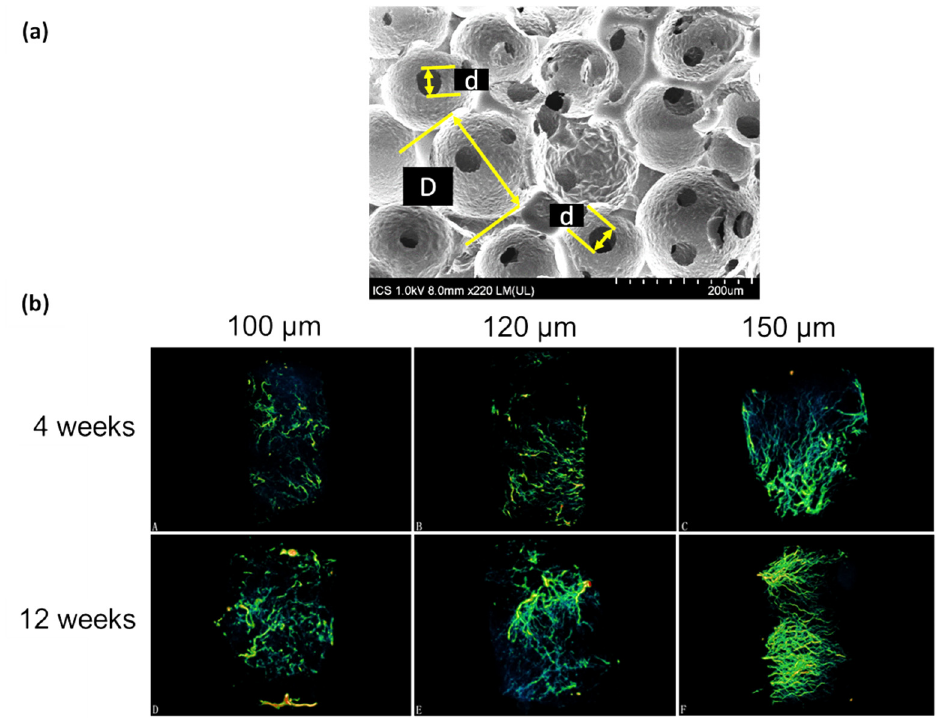
Figure 5. ( a ) SEM image of a porous scaffold produced by sphere templating where “D” indicates the pore diameter and “d” the interconnection diameter (Image taken by G. Lutzweiler). ( b ) Evolution of the blood vessels within a porous scaffold as a function of time with varying interconnection diameters (100, 120, and 150 µm). Adapted from Xiao et al . [149] (Creative Commons CC BY).